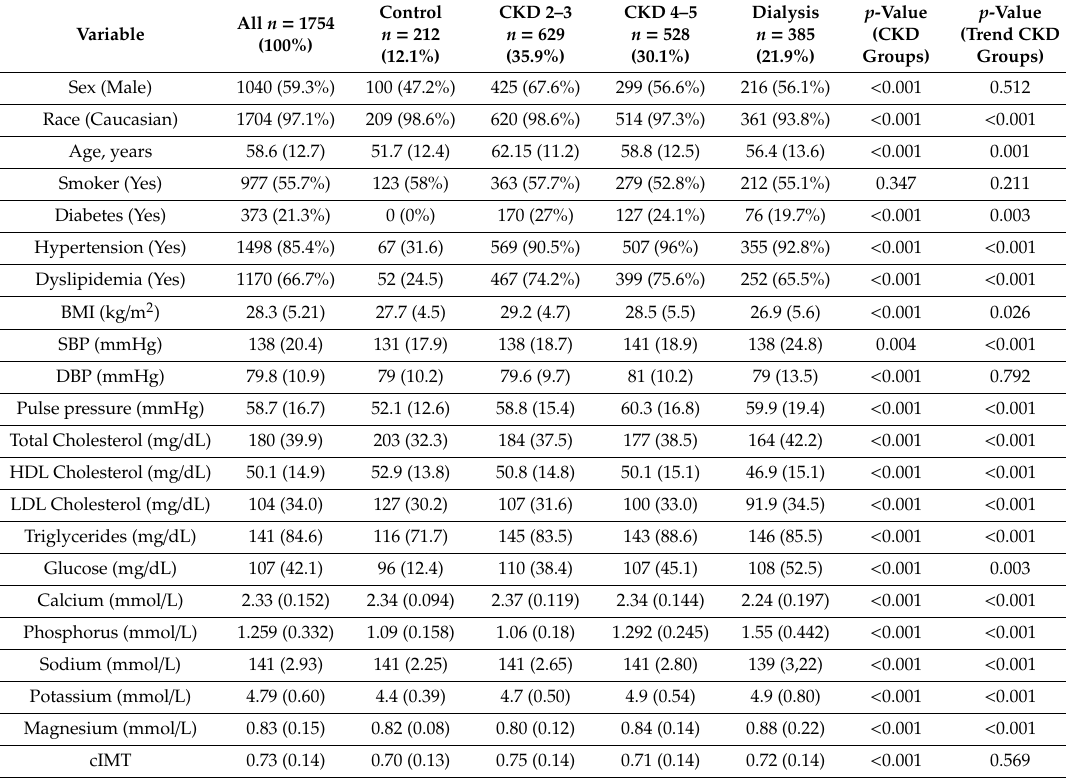
Table 1. Clinical characteristics of the cohort.